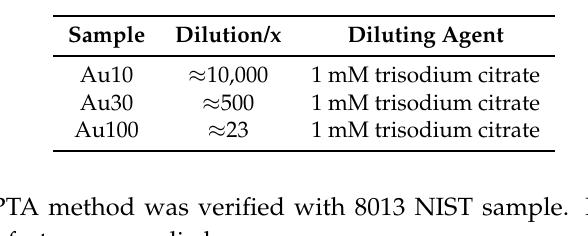
Table A1. Samples analyzed with particle tracking analysis (PTA).